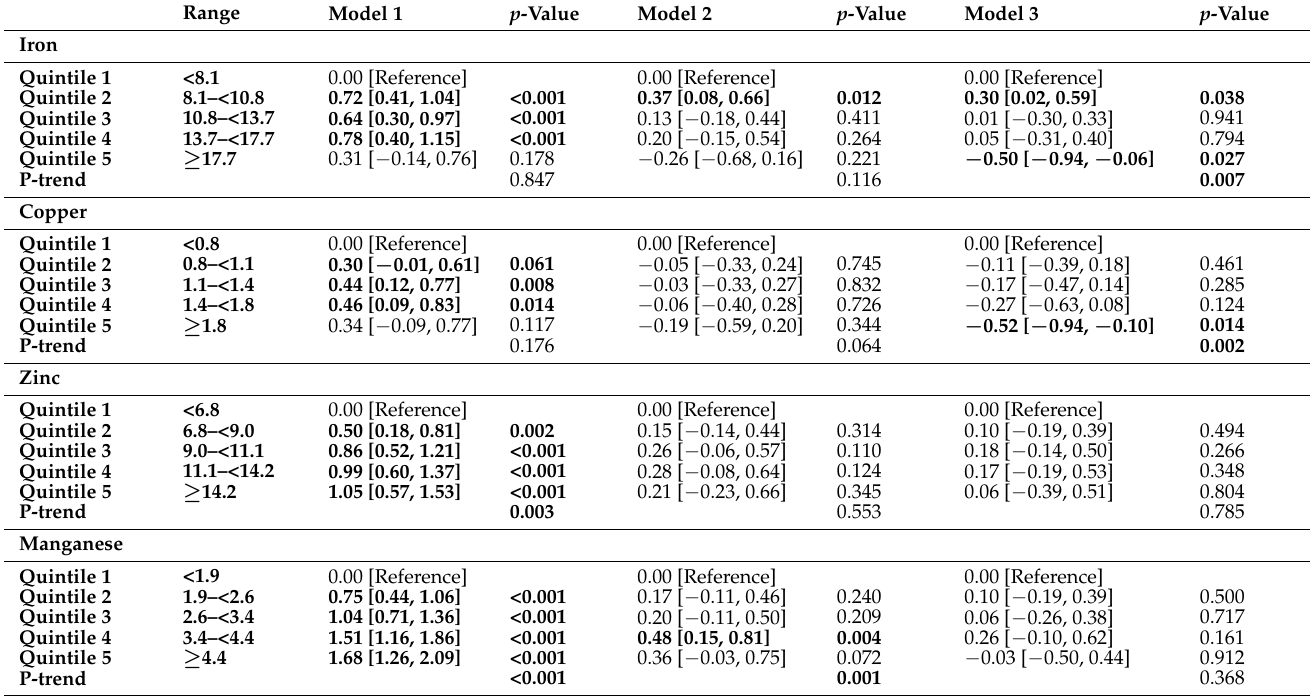
Table 2. Beta and 95% confidence intervals of global cognitive score according to dietary intake